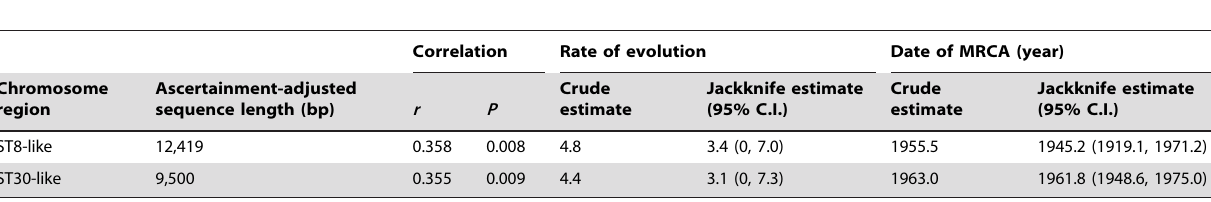
Table 3. Estimates of rate of evolution and date of the most recent common ancestor (MRCA).